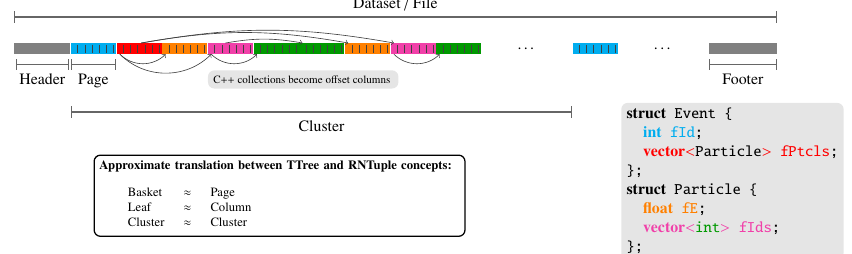
Figure 1. Breakdown of the RNTuple data layout. Each scalar field of the event struct is stored in a separate